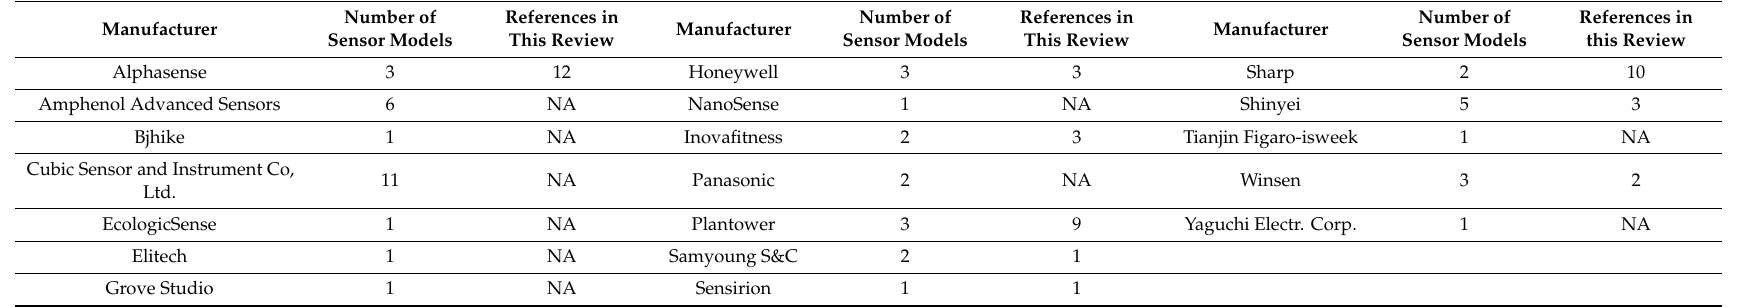
Table 4. Worldwide LCPMS manufacturers, the number of di ff erent PM sensor models they o ff er, and the number of scientific papers that have investigated their performance, either in laboratory conditions or in the